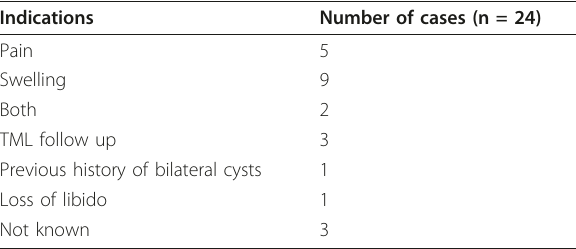
Table 1 Indications of scrotal